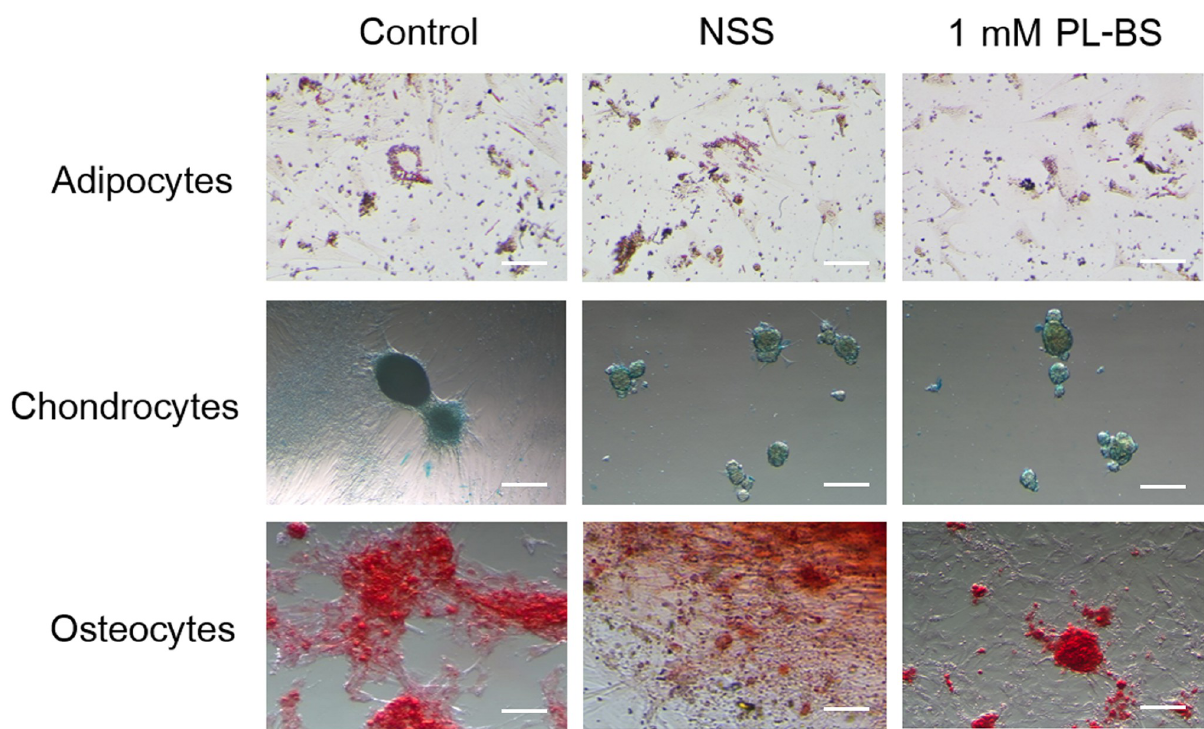
Fig 2. The effect of a hypothermic solution on trilineage differentiation of canine adipose-derived mesenchymal stem cells. The stored cAD-MSCs were able to differentiate into adipocytes, chondrocytes, and osteocytes. The red-stained fat droplets in adipocytes indicate adipogenic differentiation potential. The blue color indicates that chondrocytes are capable of producing proteoglycan in the extracellular matrix. The osteocytes that had accumulated calcium are shown in red color. Scale bars = 300 μ m. number of early apoptotic cells than those in NSS (9.91 ± 4.97%, p < 0.05), as displayed in Fig 3C.